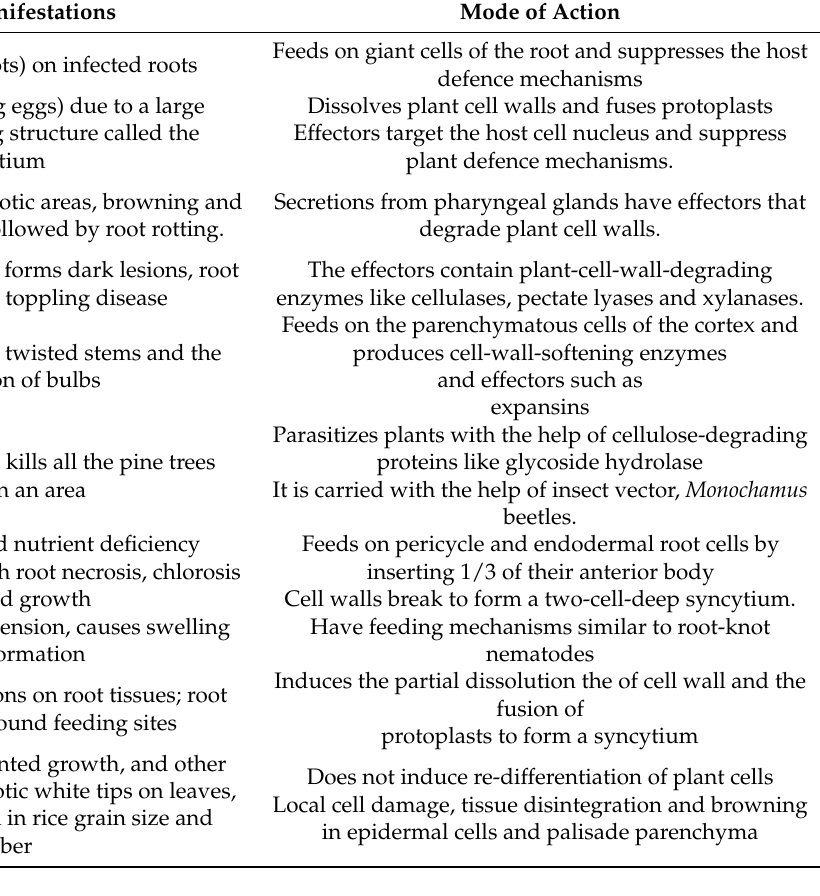
Table 3. Classification of PPN groups according to genus, feeding type, physical manifestations and mode of